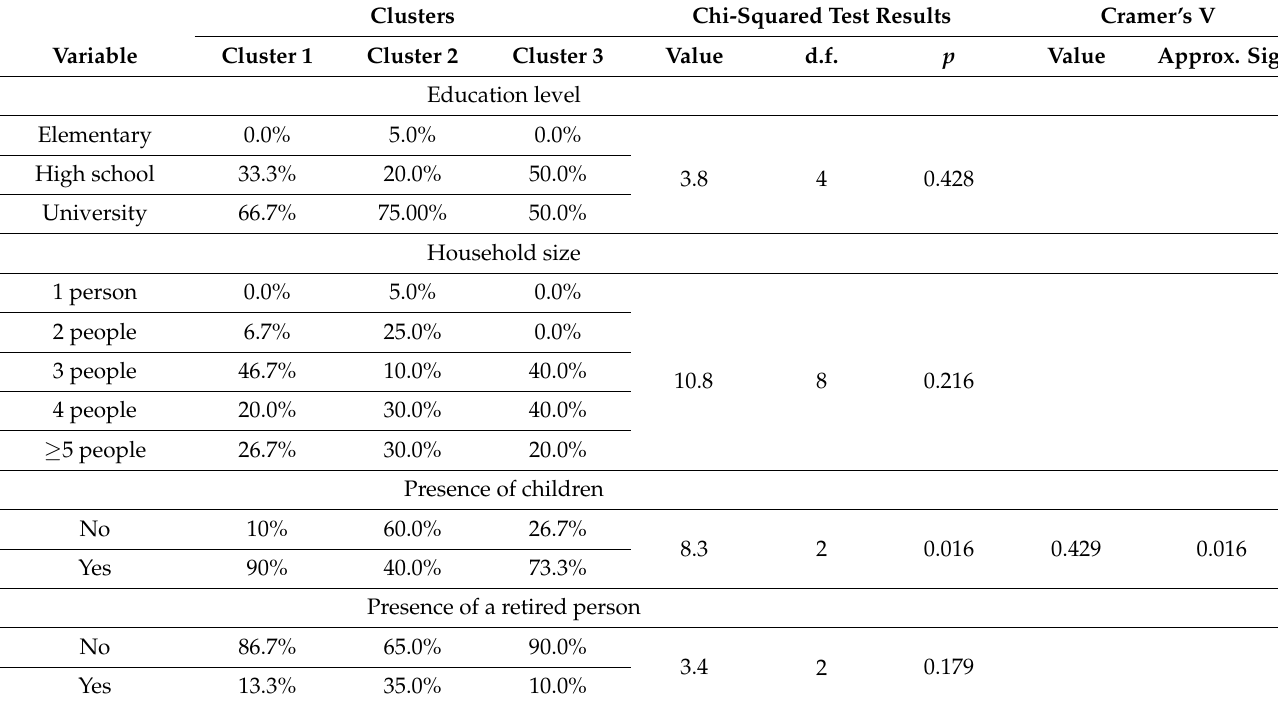
Table 12. Chi-squared analysis of socio-demographic factors between clusters in winter. Clusters